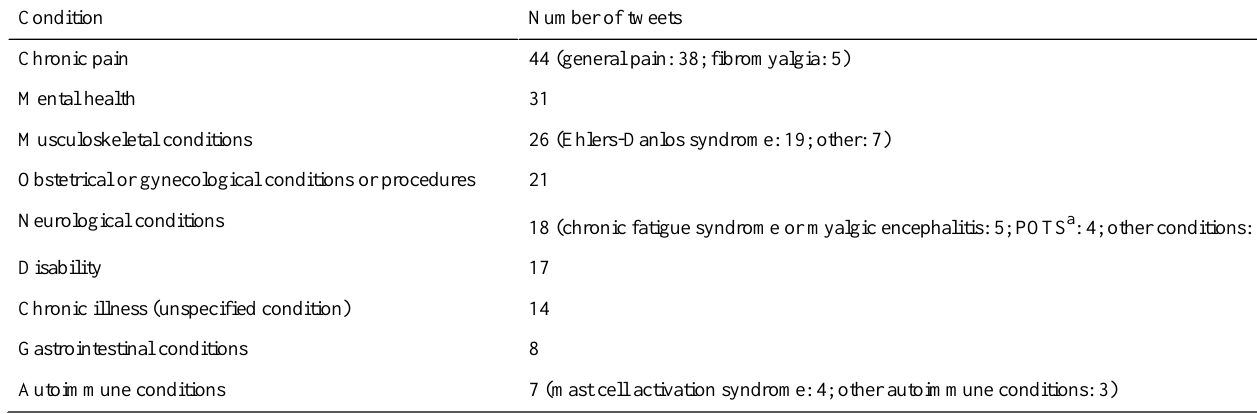
Table 2. Clinical conditions mentioned in sample tweets (n=296).